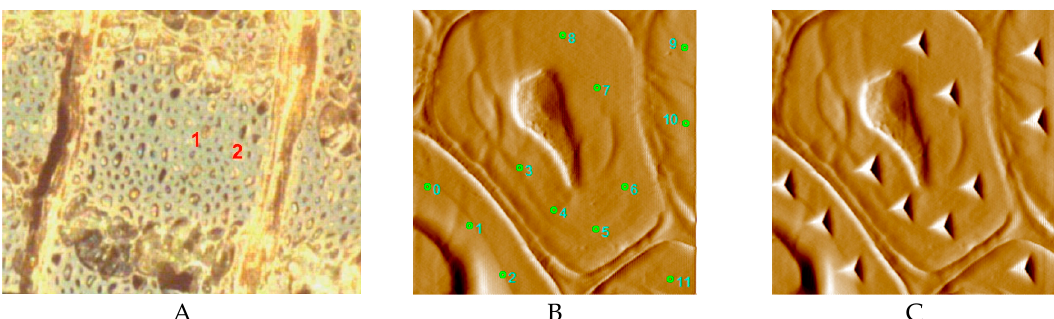
Figure 3. Procedure of an in-situ imaging NI experiment on wood cell. ( A ) region 1 and region 2 are the selected regions for NI test; ( B ) locations for NI were selected and marked; ( C ) the indentation of a region.